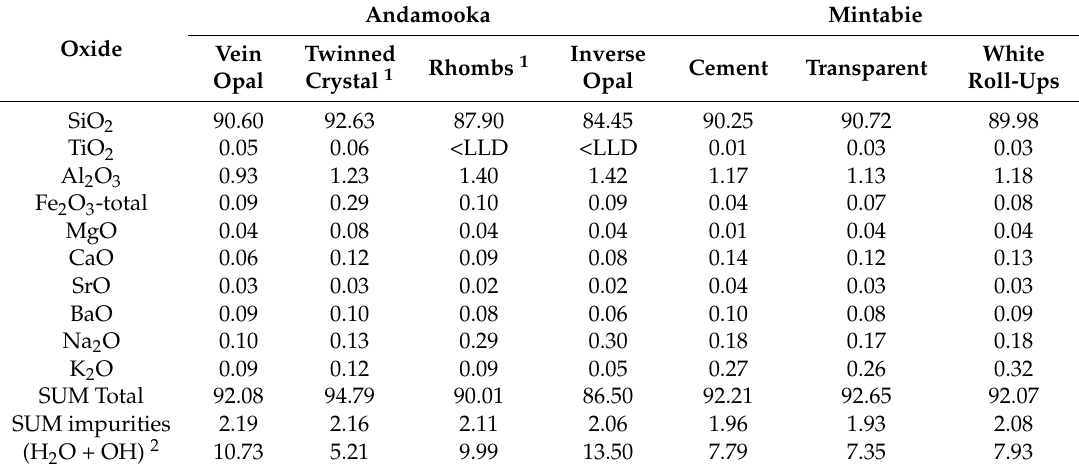
Table 1. Chemical composition of opal-A samples shown in Figures 4–6 analyzed by electron probe microanalysis (EPMA) (in wt %). The data are averaged from 30 point analyses per sample. LLD denotes lower limit of detection. Vein opal from Andamooka refers to Figure 4. Mintabie opals are shown in Figure 5. Replacement opal-A from Andamooka comprises twinned and untwinned crystals shown in Figure